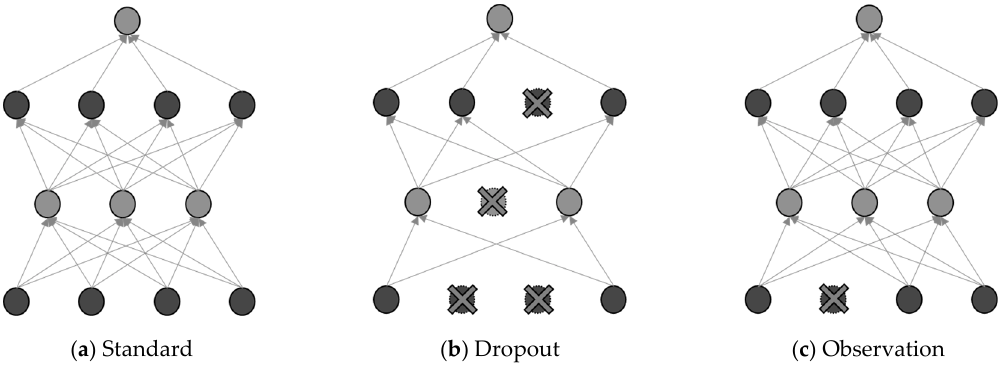
Figure 3. A comparison of the network structures among the standard network, dropout network, and observation dropout.